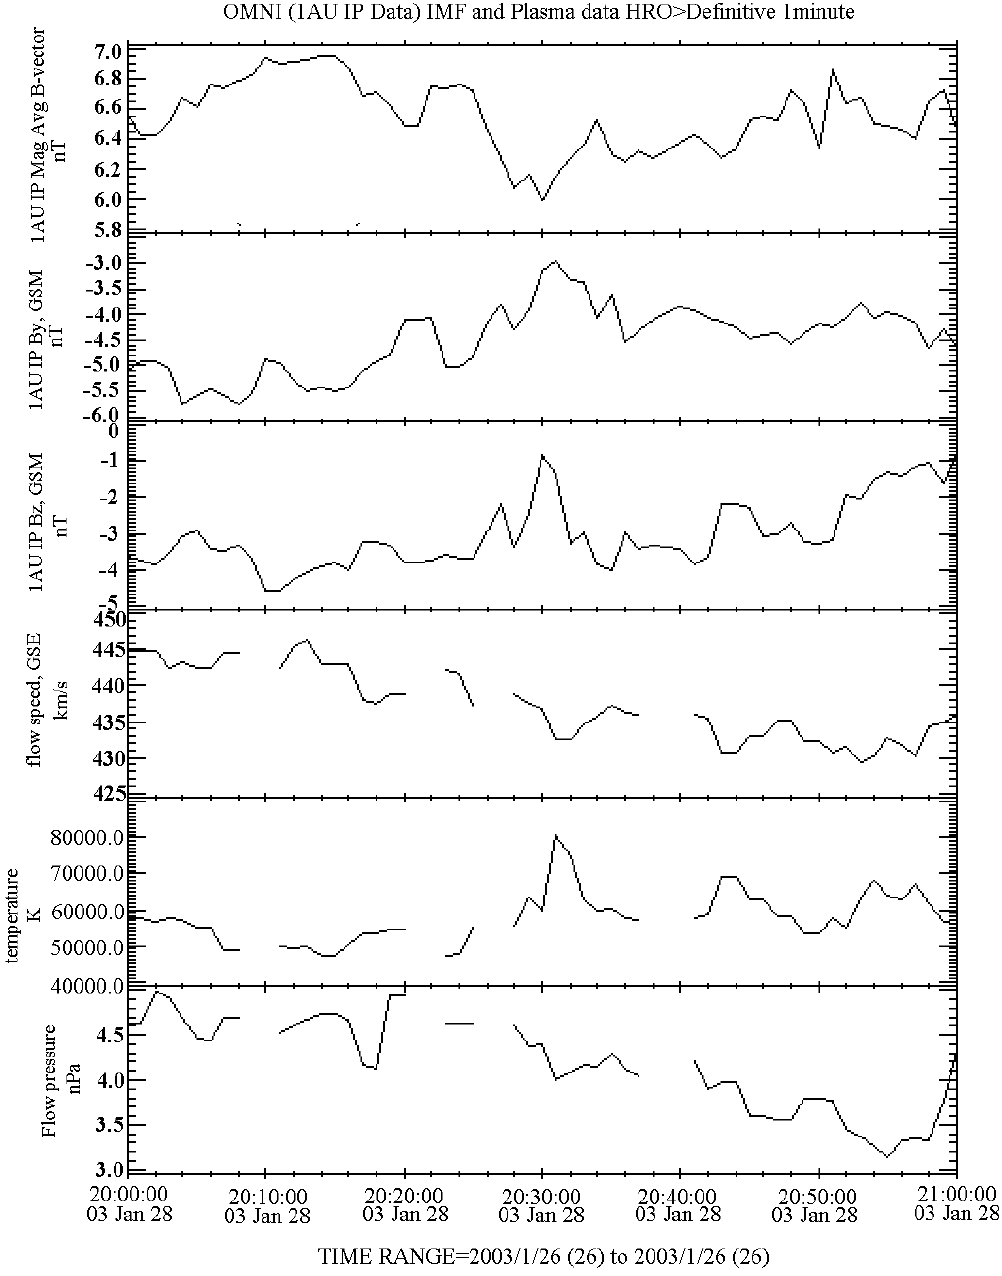
Fig. 3. Solar wind parameters for the event 28 January 2003 taken from the OMNI